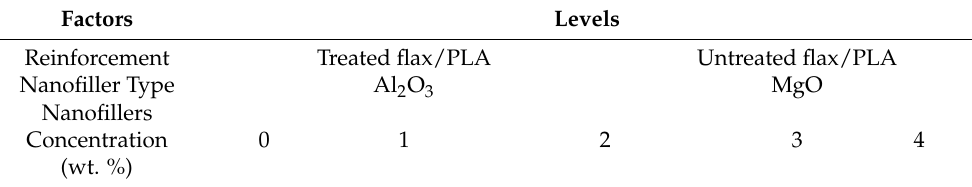
Table 2. Factors and